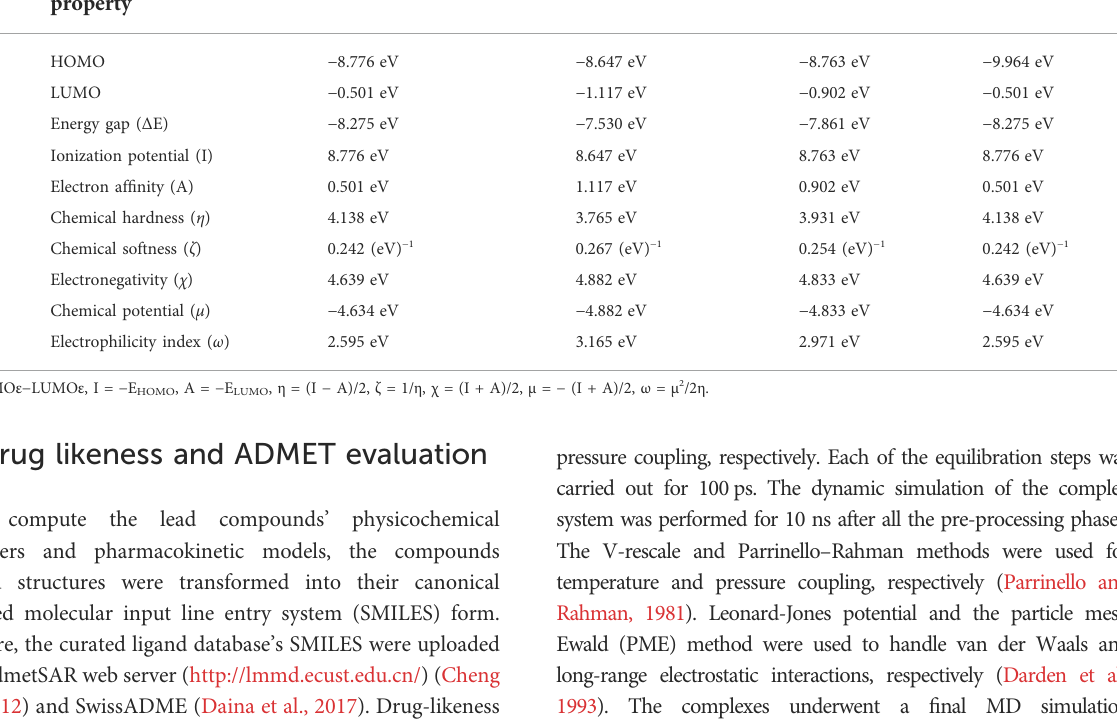
TABLE 1 Calculated quantum reactivity descriptors of top four compounds using the PM7 Hamiltonian method.